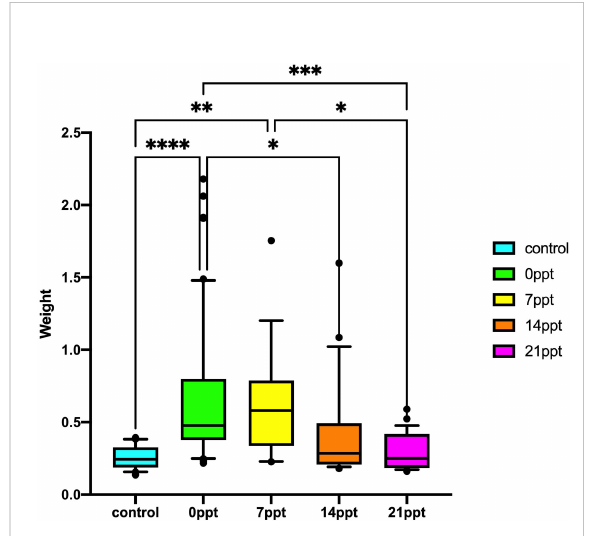
FIGURE 2 Body length performance of the M. nipponense exposed to different salinity gradients. * indicates the extent of signi fi cant difference (*: p < 0.05, **: p < 0.01, ***: p < 0.001, ****: p <